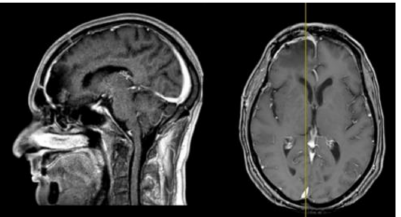
Figure 2. Post-operative brain MRI T1-weighted with contrast images showing the complete removal of the anterior cranial fossa meningioma.